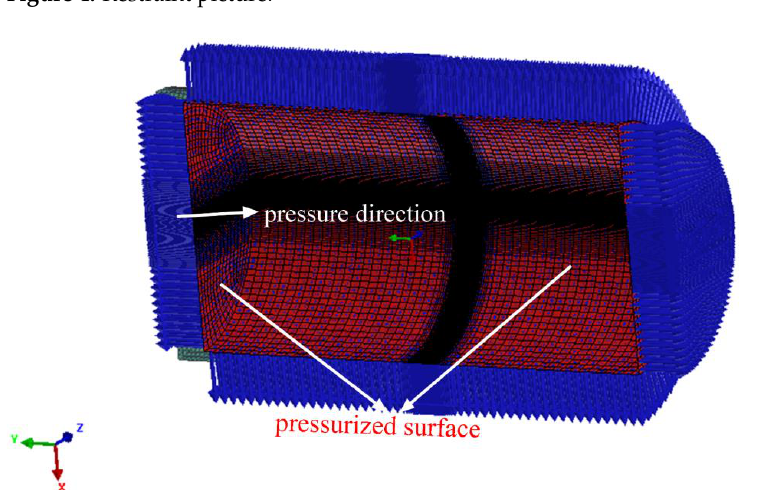
Figure 4. Restraint picture.